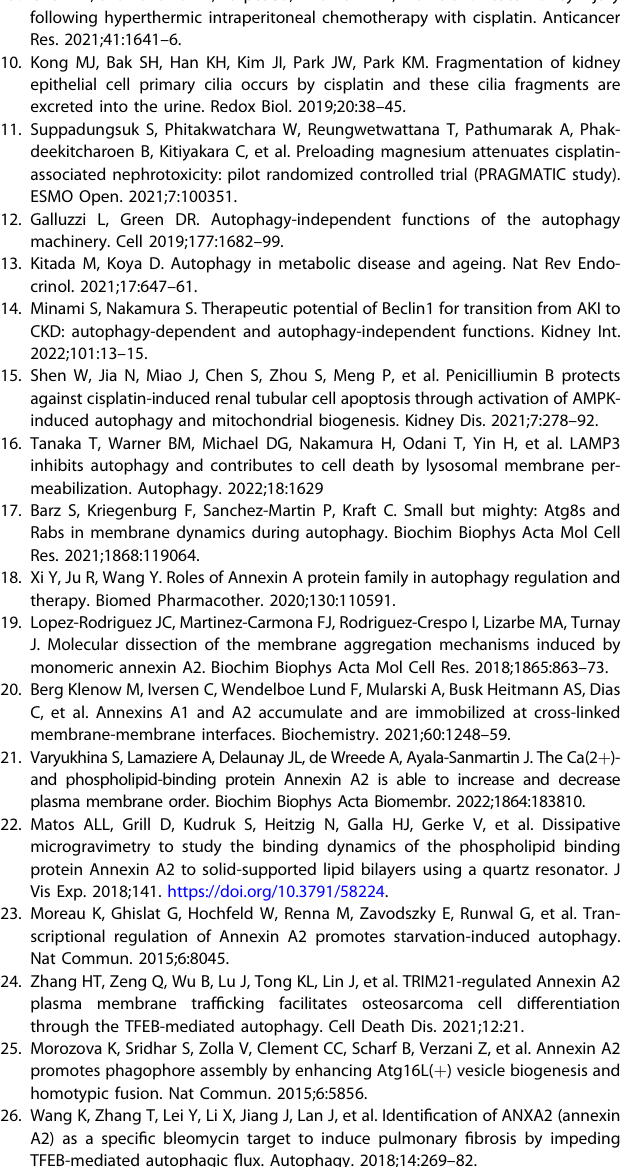
Fig. 9 ANXA2 promotes lysosomal functions through β -catenin/TCF4/TFEB signaling. Representative western blotting ( A ) and quantitative data of the expression of β -catenin ( B ) and TFEB ( C ) in total protein, β -catenin ( D ) and TFEB ( E ) in nuclear protein are shown. * P < 0.05, ** P < 0.01, *** P < 0.001 versus pcDNA3 ( n = 3); # P < 0.05, ### P < 0.001 versus pCMV-ANXA2 alone ( n = 3). HK-2 cells were transfected with ANXA2 expression plasmid for 6 h, and then treated with ICG-001 (10 μ m) for 24 h. F Bioinformatics assay showing the potential binding sites of TCF/LEF consensus in TFEB promoter region. G qPCR results showing the mRNA level of TFEB in 2 groups. * P < 0.05 versus pcDNA3 ( n = 3). H Luciferase assay shows the transcriptional activity of TFEB. HK-2 cells were transfected with TCF4 or ANXA2 expression plasmid or pcDNA3, and co-transfected with pGL3-TFEB reporter plasmid. The transcriptional activity of TFEB was detected by the relative activity of luciferase. ** P < 0.01, pCMV-TCF4 ( n = 3) versus ctrl ( n = 3); ## P < 0.01, pCMV-ANXA2 ( n = 3) versus pCMV-TCF4 ( n = 3). I Representative ChIP-PCR analysis shows the binding of TCF4 antibody to TFEB promoter. HK-2 cells were transfected with ANXA2 expression plasmid or pcDNA3 for 24 h. Cell lysates were precipitated with an antibody against TCF4, histone H3, or nonimmune IgG, and the ChIP assay was performed for TFEB gene promoter. Total diluted lysate was used as total genomic input DNA. J qPCR results showing the mRNA level of TFEB in different groups. HK-2 cells were transfected with ANXA2 expression plasmid or co-transfected with TCF4 expression plasmid or siRNA to TCF4. * P < 0.05 versus